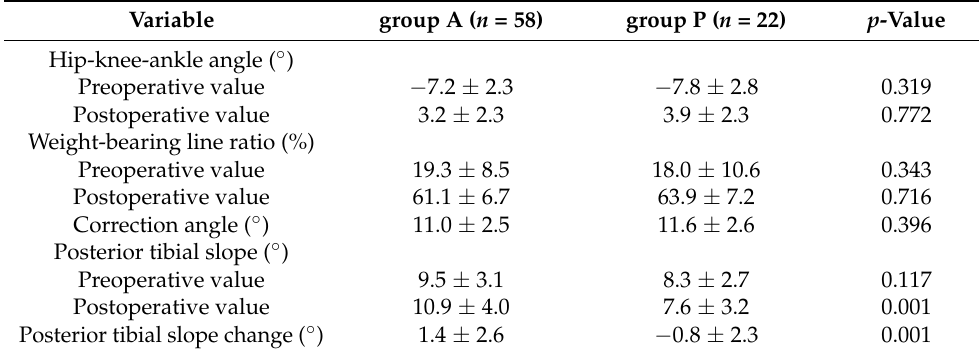
Table 2. Preoperative and postoperative measurement on the plain